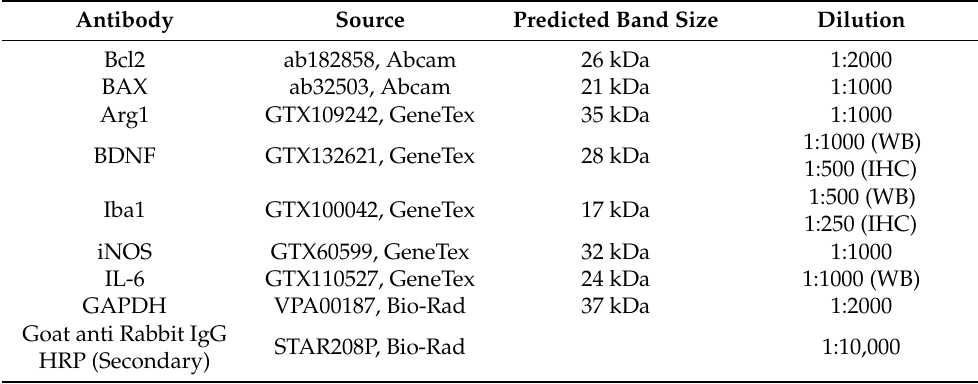
Table 2. Antibodies used in Western